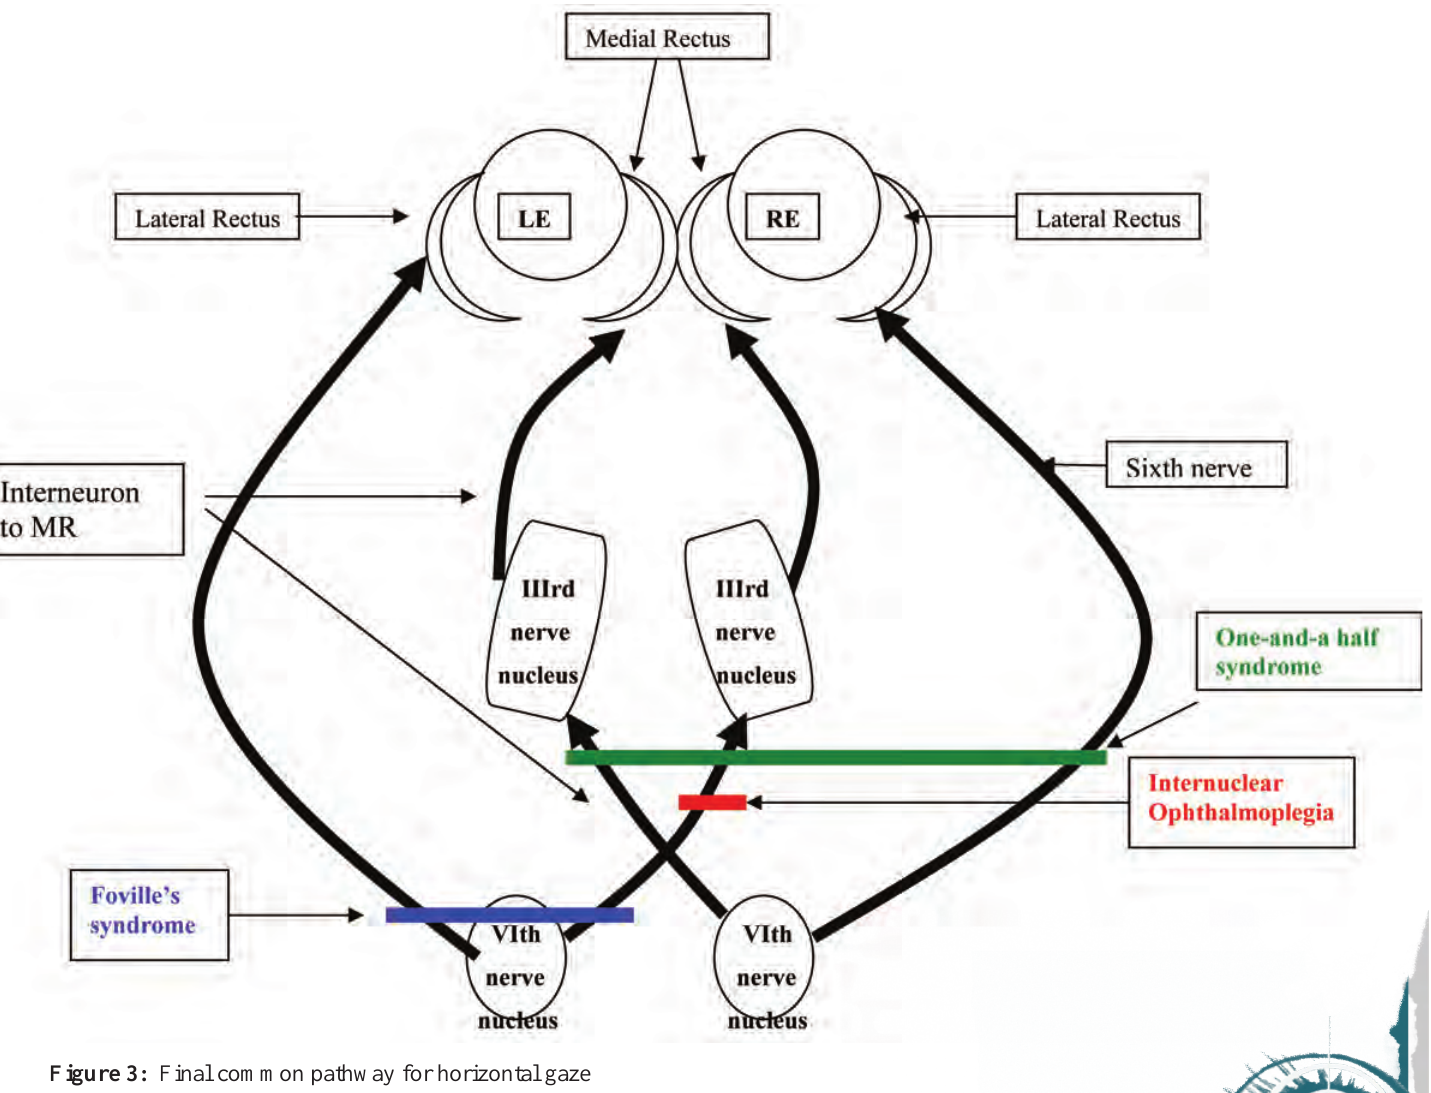
Figure 3: Final common pathway for horizontal